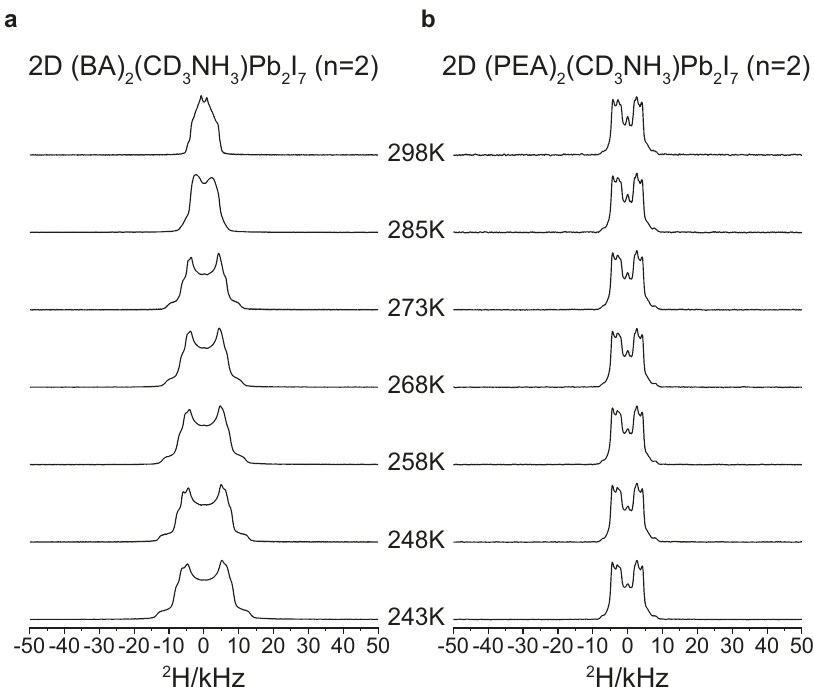
Fig. 4 2 H NMR spectra of 2D OIHP crystals ( n = 2). The full-scale 2 H spectra of a 2D (BA) 2 (d 3 -MA)Pb 2 I 7 ( n = 2) and b 2D (PEA) 2 (d 3 -MA)Pb 2 I 7 ( n = 2) recorded at various temperatures, ranging from 298 to 243